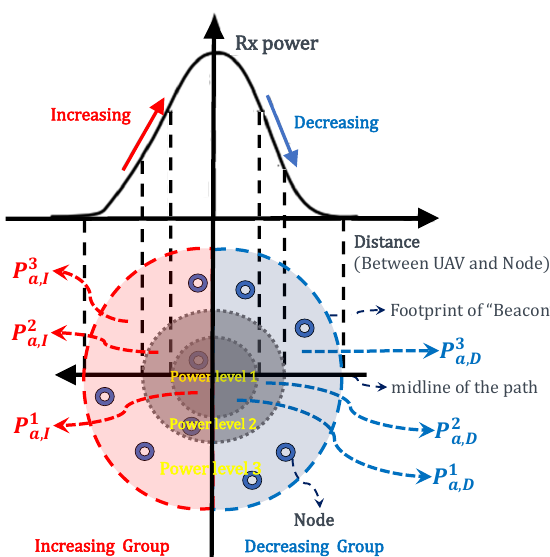
Figure 2. The Priority Frame Selection (PFS)